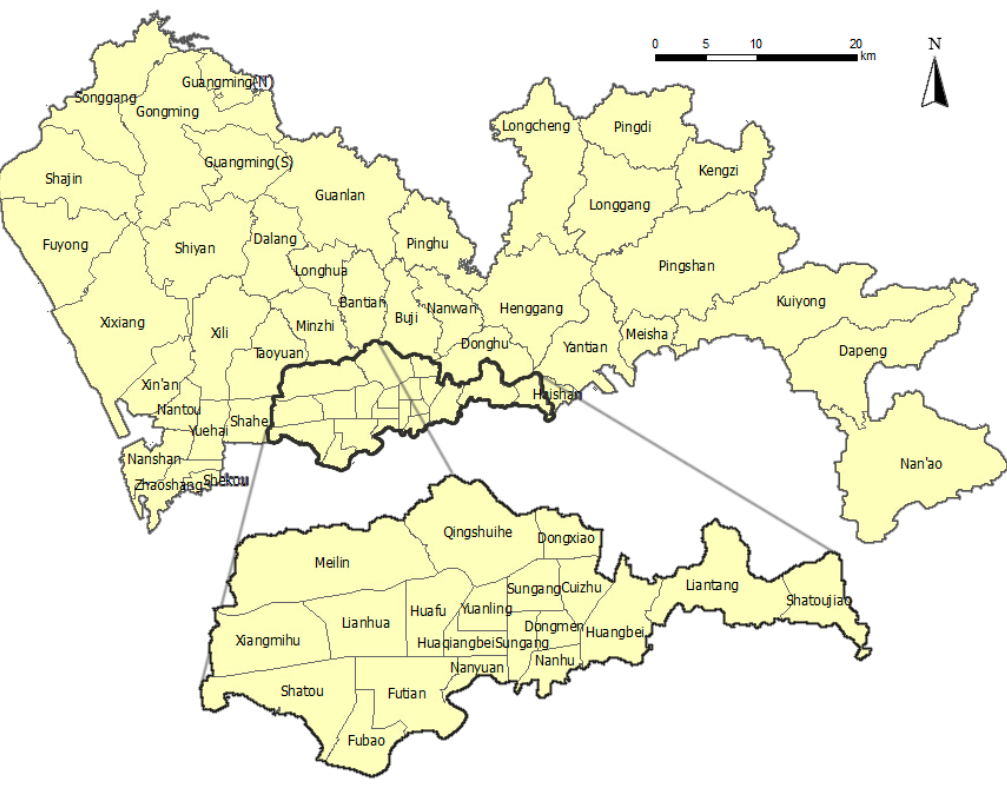
Figure 2. Sub-districts (Jie Dao) of Shenzhen.